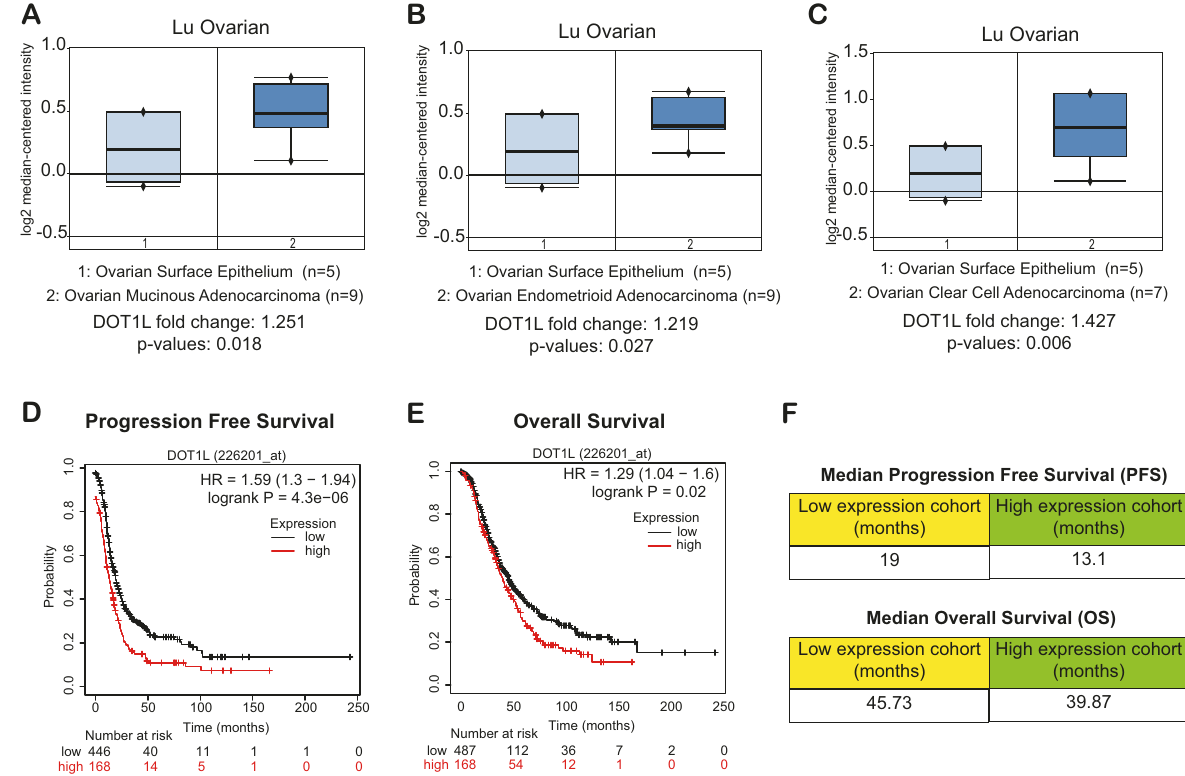
Fig. 1 DOT1L is overexpressed in patient-derived samples of ovarian cancer. A – C The indicated ovarian cancer patient datasets were analyzed for DOT1L mRNA expression. Upregulation of DOT1L mRNA in ovarian cancer samples compared with normal ovarian surface epithelium cells is indicated. D , E The effects of DOT1L expression on progression-free survival and overall survival were analyzed using a Kaplan – Meyer plotter. F Median progression-free survival and overall survival of patients with low or high DOT1L RESULTS DOT1L is overexpressed in ovarian cancer and its overexpression is associated with a poor prognosis To understand the role of DOT1L in ovarian cancer, we fi rst asked if DOT1L expression is altered in ovarian cancer, and if so, whether its expression is associated with disease outcomes. Analysis of publicly available ovarian cancer datasets revealed that DOT1L mRNA was signi fi cantly higher in patient-derived samples of ovarian cancer than in corresponding normal tissues [20] (Fig. 1A – C). Furthermore, patients with ovarian tumors with high DOT1L expression had shorter progression-free survival (PFS) and (OS) than patients with ovarian tumors with low DOT1L expression (Fig. 1D, E). The median PFS of patients with low DOT1L expression was 19 months, whereas that of patients with high DOT1L expression was only 13.1 months. Similarly, the median OS of patients with low DOT1L expression was 45.73 months, whereas that of patients with high DOT1L expression was 39.87 months (Fig. 1F). Collectively, those results indicated that DOT1L is overexpressed in ovarian cancer and that its overexpression is associated with poor prognosis. DOT1L inhibition blocks the growth of ovarian cancer cells in vitro and in a xenograft model of ovarian cancer DOT1L methylates lysine 79 of nucleosomal histone H3 (H3K79) and EPZ-5676, (also known as Pinometostat) is an S -adenosyl methio- nine competitive inhibitor of DOT1L. EPZ-5676 has an inhibitory constant (Ki) of 80 pM in a cell-free assay and has demonstrated >37,000-fold selectivity for DOT1L relative to all the other protein methyltransferases tested [21] (Fig. 2A, B). In cell culture, EPZ-5676 inhibited H3K79 methylation and MLL-fusion gene expression and